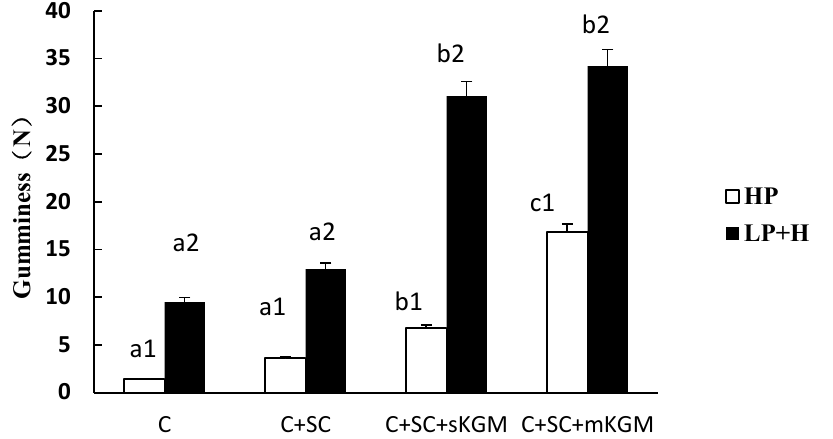
Figure 4. Effects of addition of various levels of SC and KGM on the gumminess of different gels.